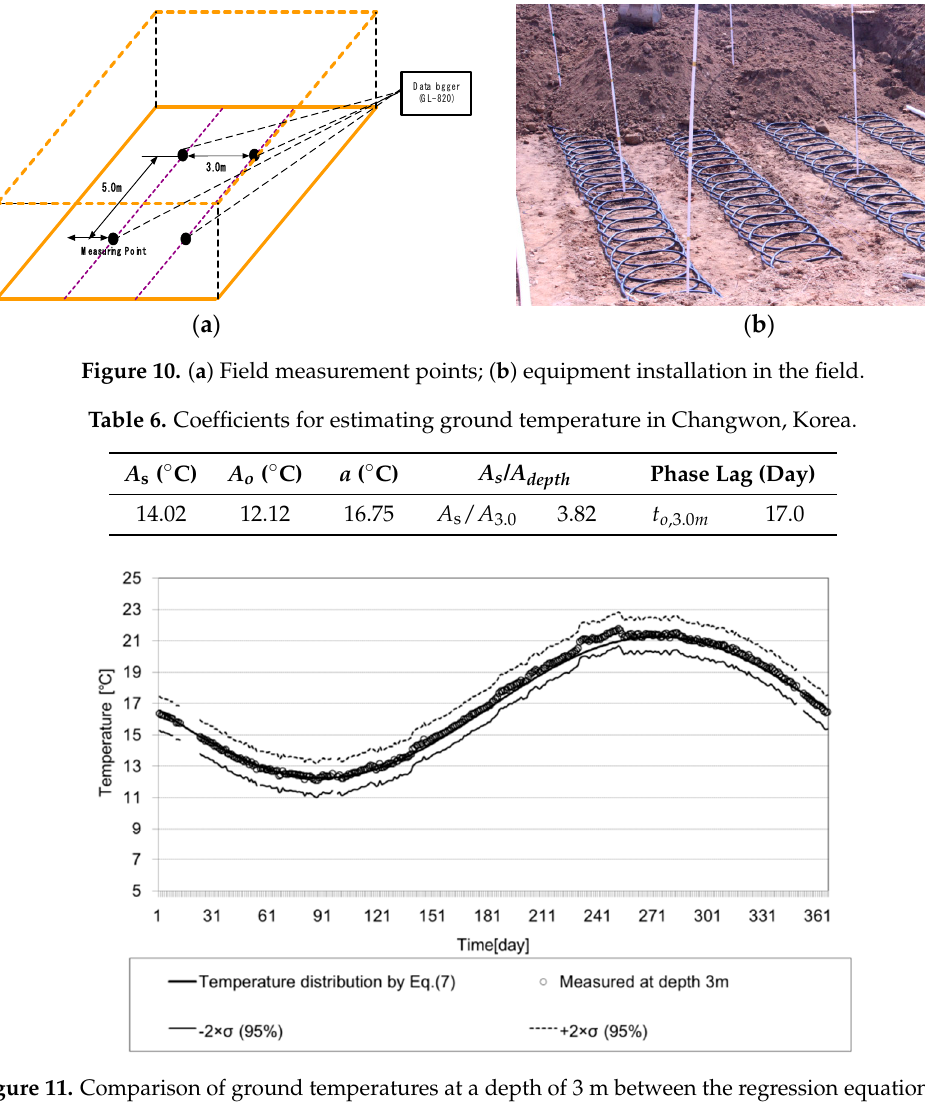
Figure 11. Comparison of ground temperatures at a depth of 3 m between the regression equation and field measurements in 2017 in Changwon, Korea.